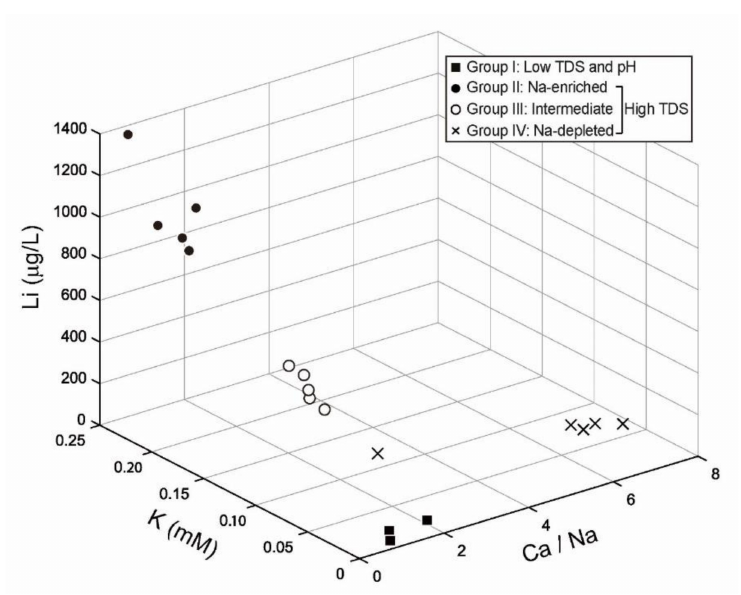
Figure 8. Useful hydrochemical parameters: Li, K, and Ca /